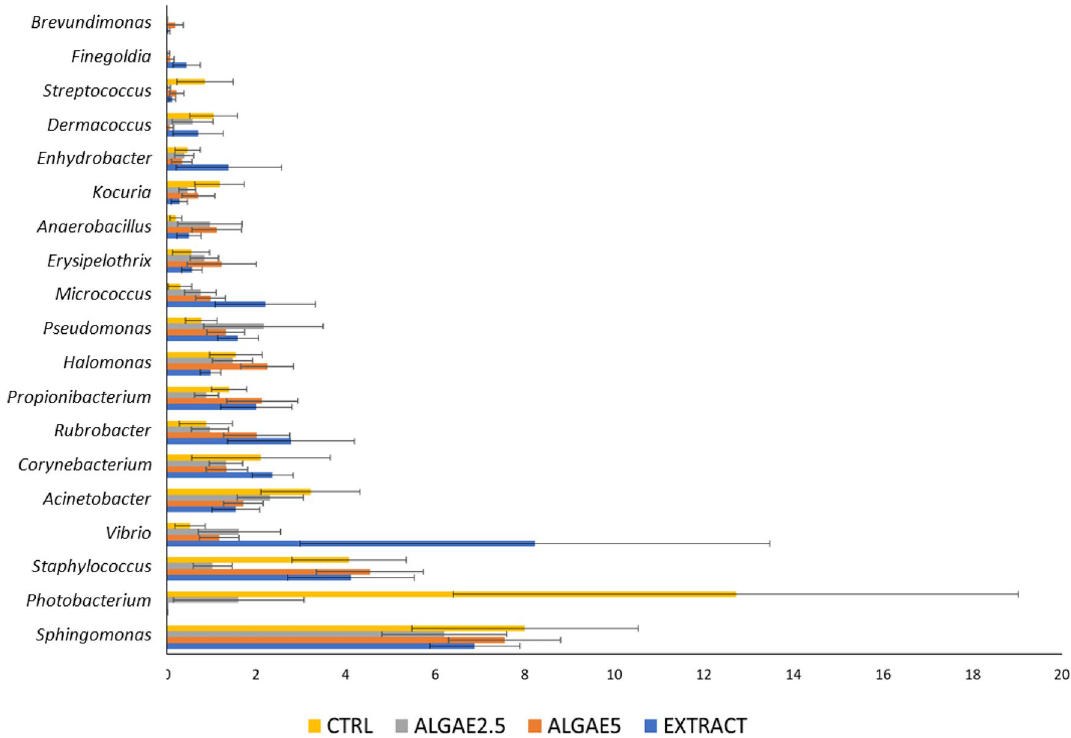
Figure 4. Relative abundance of most abundant genera in European seabass gut microbial communities when fed the experimental diets, and these were a basal diet with no supplement (CTRL) or supplemented with Gracilaria gracilis powdered biomass at 2.5% (ALGAE2.5), at 5% (ALGAE5) or with the seaweed extract at 0.35% inclusion rate (EXTRACT). Bars and errors indicate mean ± SD of differentially abundant genera (ANOVA, P <